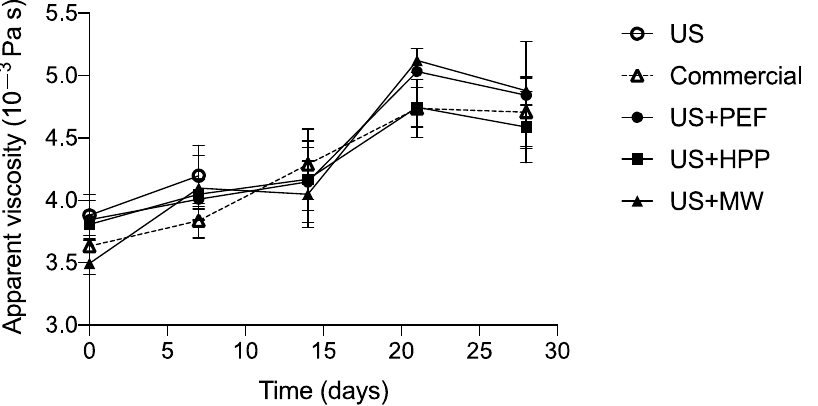
Figure 5. Apparent viscosity of milk samples during their shelf life. The values shown are the mean values ( n = 4), and the standard error of means is shown as whiskers.